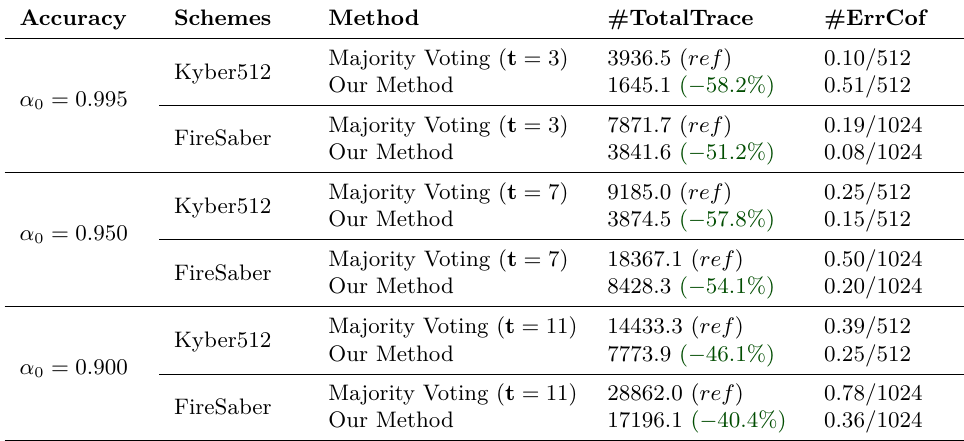
Table 6: Comparison between majority-voting and our proposed method for full-key recovery under O ( t represents the number of votes cast) SCA Accuracy